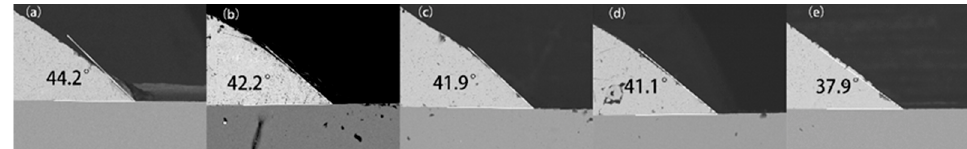
Figure 7. Contact angle image of Sn-9Zn-xBi alloy: ( a ) x = 1; ( b ) x = 2; ( c ) x = 3; ( d ) x = 4; ( e ) x = 5.